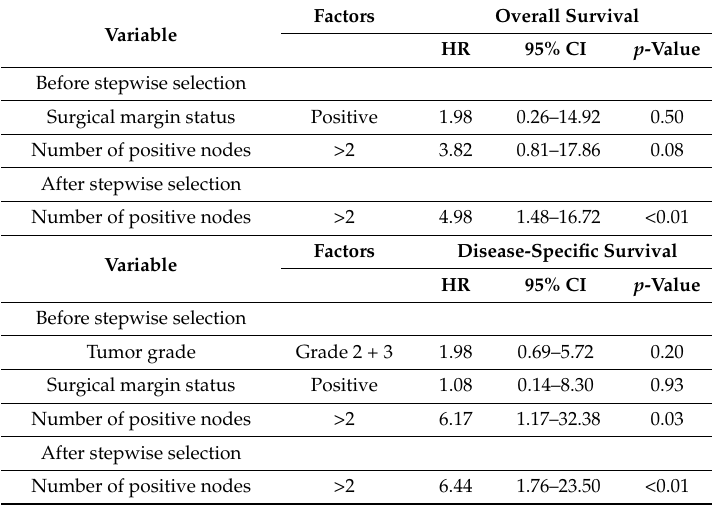
Figure 1. The five-year Kaplan–Meier survival estimates by extent of neck dissection for overall survival ( A , C and E ) and disease-specific survival ( B , D and F ); A and B show the survival curves of cN0, cN1 versus cN2. C and D show the survival curves of pN1 versus pN2 versus pN3. According to the number of positive lymph nodes (divided into ≤ 2: E , F and >2: E , F ). Table 5. Multivariate Cox hazards regression model for the factors influencing overall survival and disease-specific survival in patients with node-positive squamous cell carcinoma who underwent selective neck